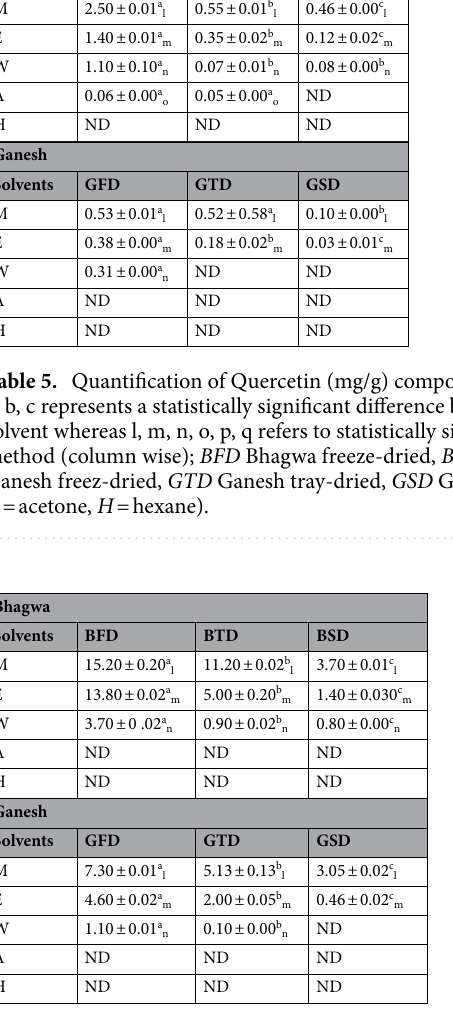
Table 6. Quantification of Punicalagin(mg/g) compounds from pomegranate peel extract. Mean ± SD n = 3, a, b, c represents a statistically significant difference between drying methods in row wise manner for specific solvent whereas l, m, n, o, p, q refers to statistically significant difference among solvents for respective drying method (column wise); BFD Bhagwa freeze-dried, BTD Bhagwa tray-dried, BSD Bhagwa sun-dried,